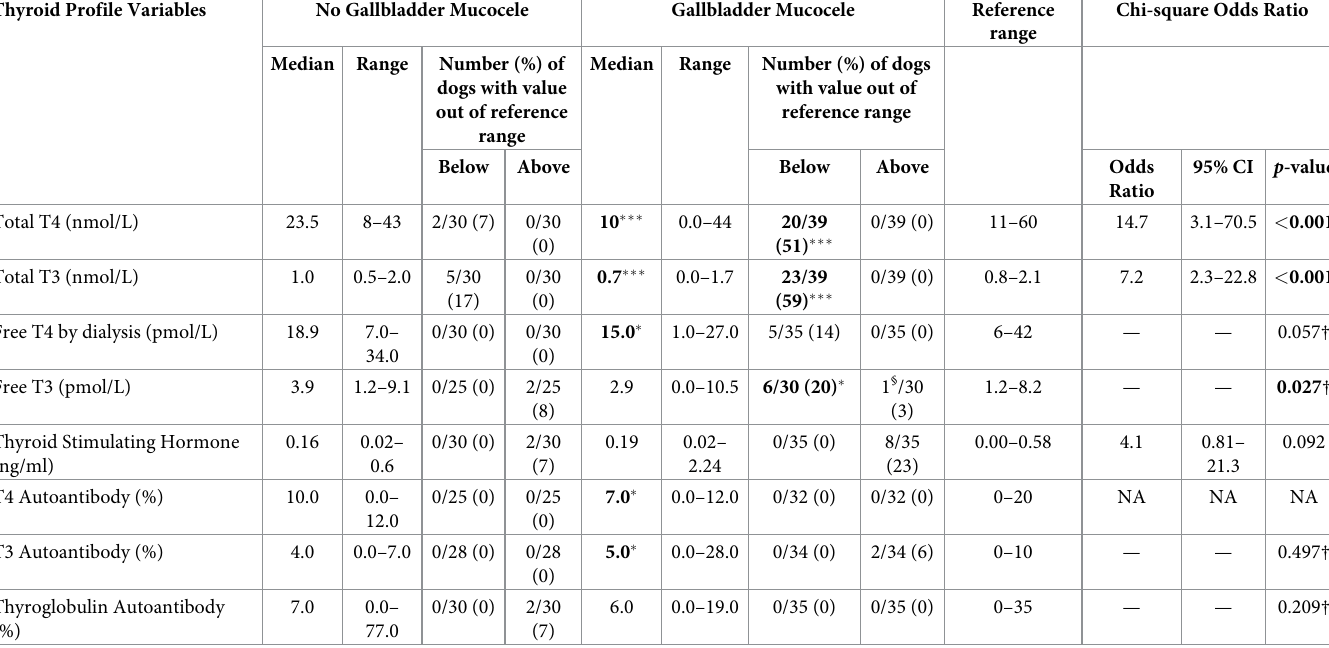
Comparison of median values performed using Kruskal-Wallis One Way ANOVA on Ranks. Comparison of proportions performed using Chi-square statistic.